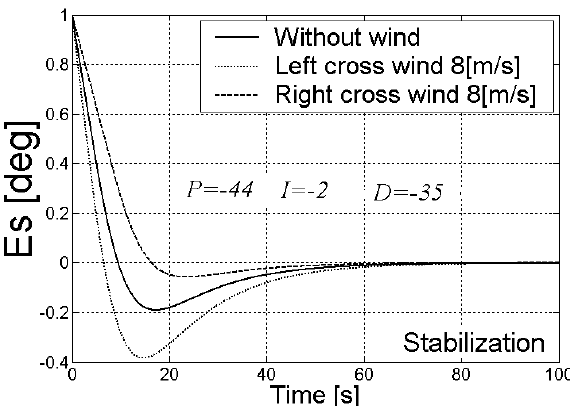
Fig 3a. Simulation results for whole approach with the use of control laws (9) for interception and based on PID for stabilization